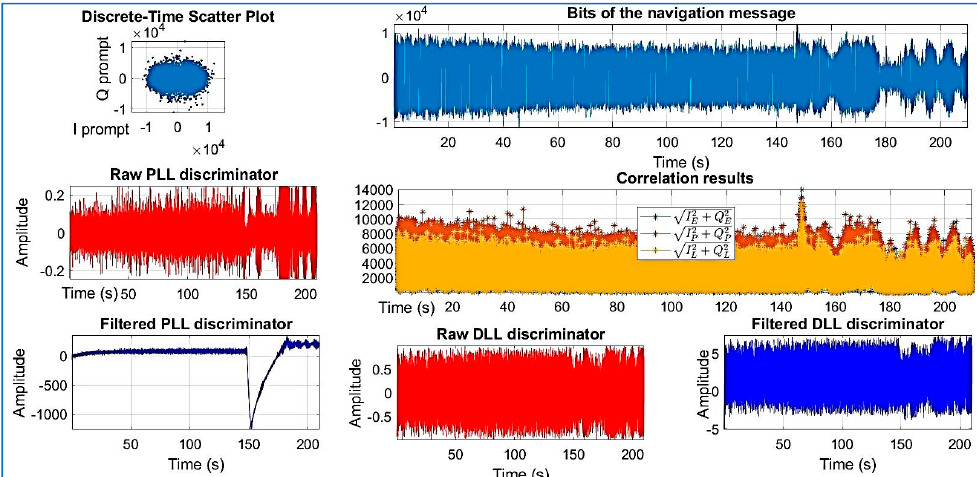
Figure 20. PRN 31, channel 03, Dataset 3.